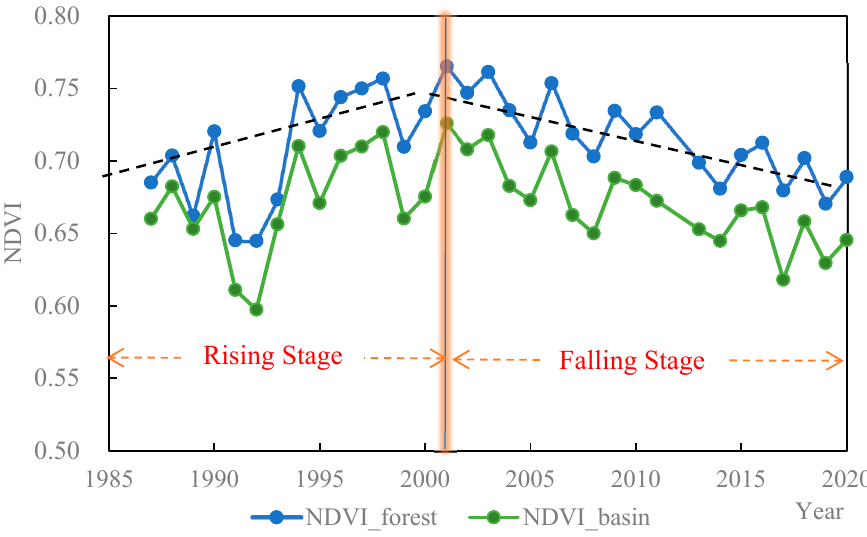
Figure 3. NDVI profiles from 1987 to 2020 in Lijiang River Basin.